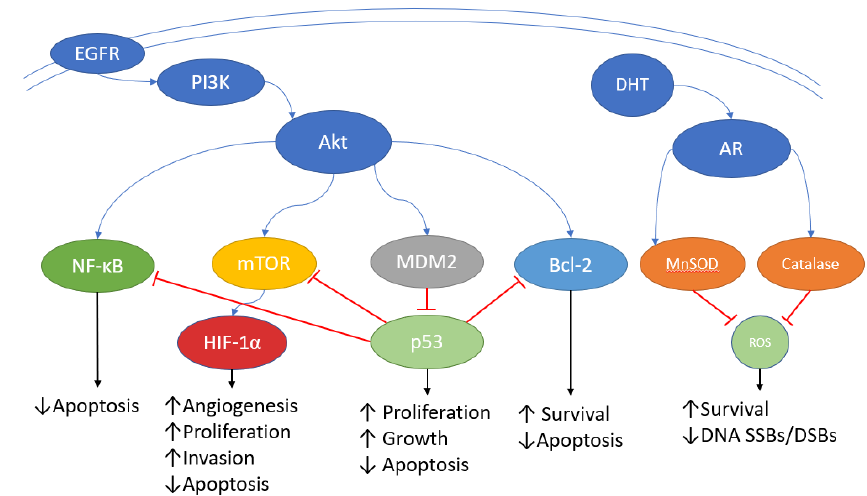
Figure 1. Pathways involved in the promotion of radioresistance in PCa. Overexpression of growth factor receptors such as the epidermal growth factor receptor (EGFR) promotes phosphatidylinositol 3-kinase (PI3K) activation which then activates protein kinase-B (Akt). Akt leads to increased expression nuclear factor kappa B (NF- κB), mammalian target of rapamycin (mTOR) and Bcl-2 which are all linked to radiosensitivity. Akt also increases expression of MDM2 which is a negative regulator of p53 activity. Androgen receptor (AR) activation by dihydrotestosterone (DHT) promotes activity of the antioxidants, manganese superoxide dismutase (MnSOD) and catalase, resulting in decreased reactive oxygen species (ROS) levels promoting radioresistance through reduced DNA double strand (DSB) and single strand breaks (SSB).